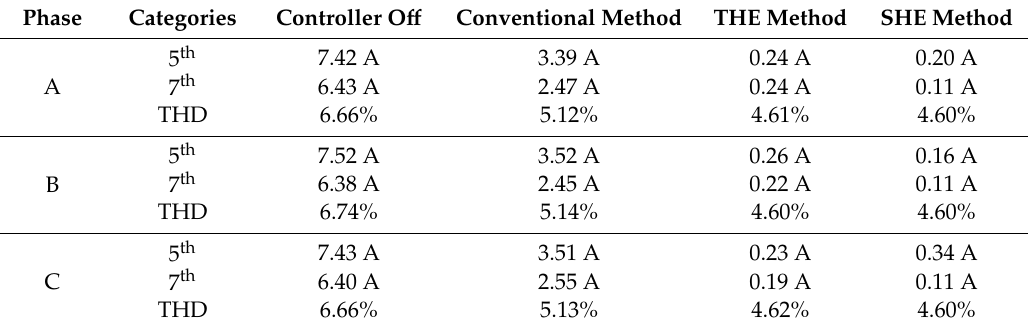
Table 7. Analysis of output current depending on the harmonic compensation